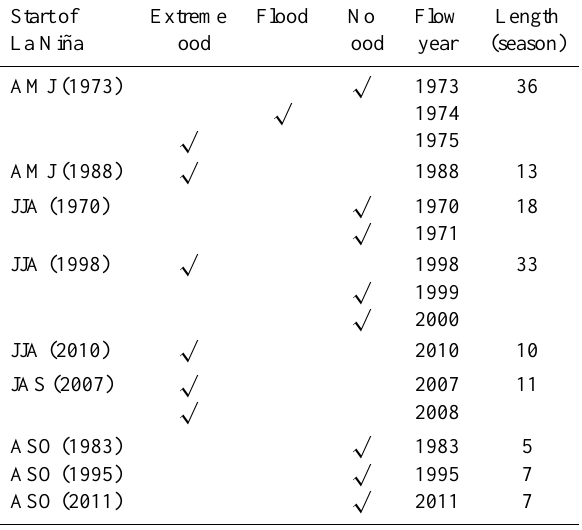
Table 3. The effect of the start of La Niña in the flood of the upper catchment of the Blue Nile during JJAS of the same